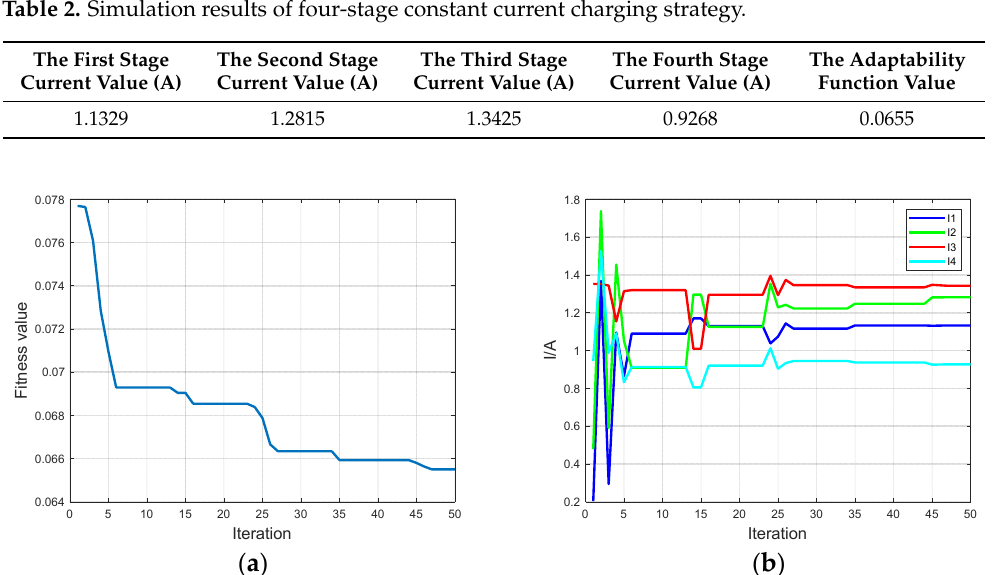
Table 3. Simulation results of five-stage constant current charging strategy.